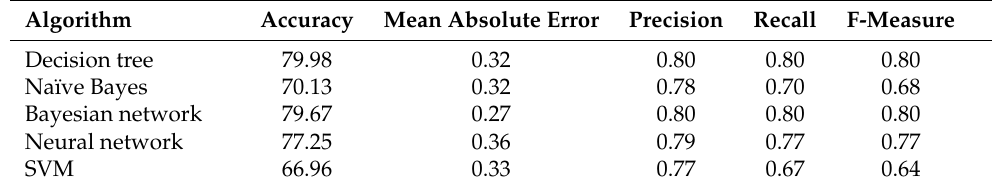
Table 14. LOC and readability metrics results for PCA dimension reduction approach using percent- age split.